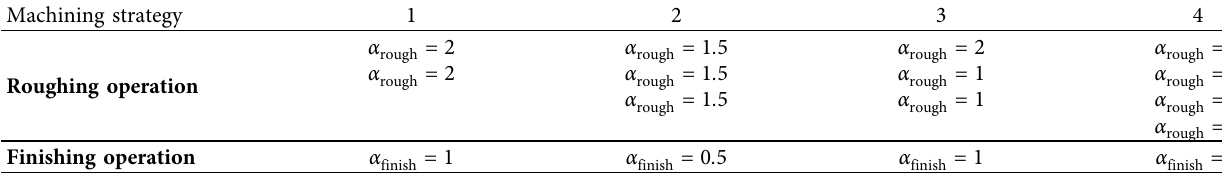
Table 2: Four machining strategy options.